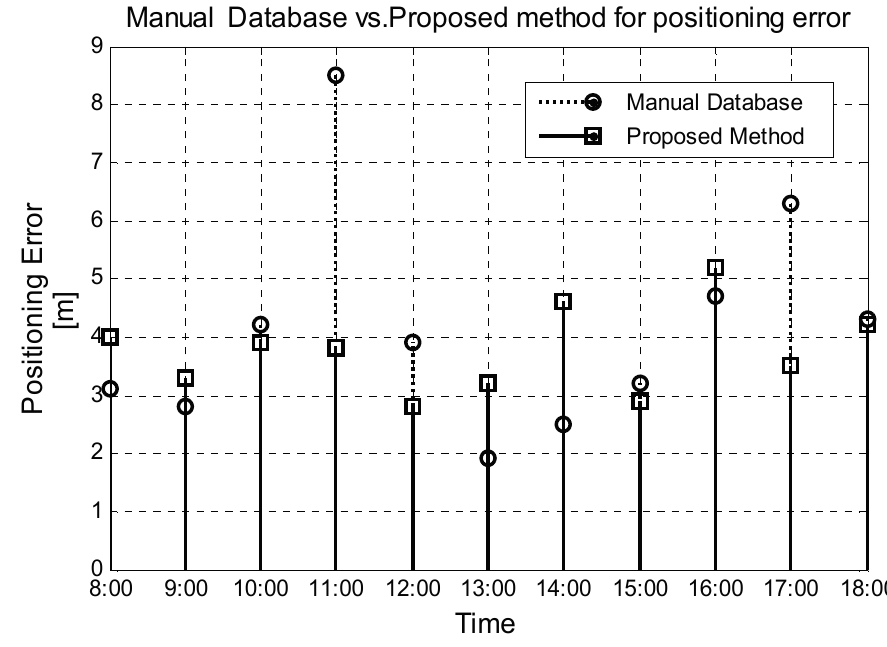
Figure 7. Comparison between the manual database and proposed method at different time.